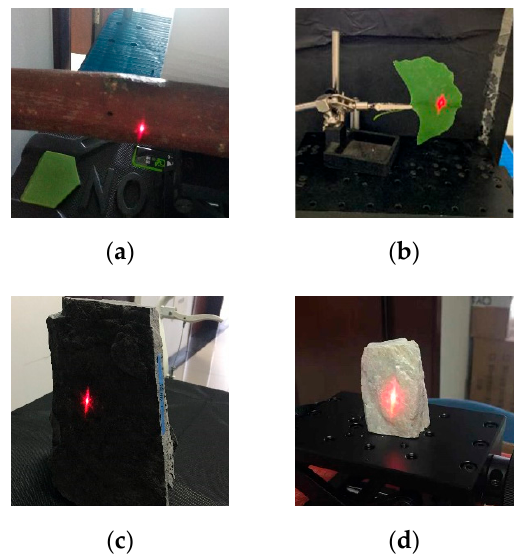
Figure 1. Some samples in lab experiment. ( a ) Goldenrain wood; ( b ) gingko leaf; ( c ) rock from roof layer; and ( d ) calcite.